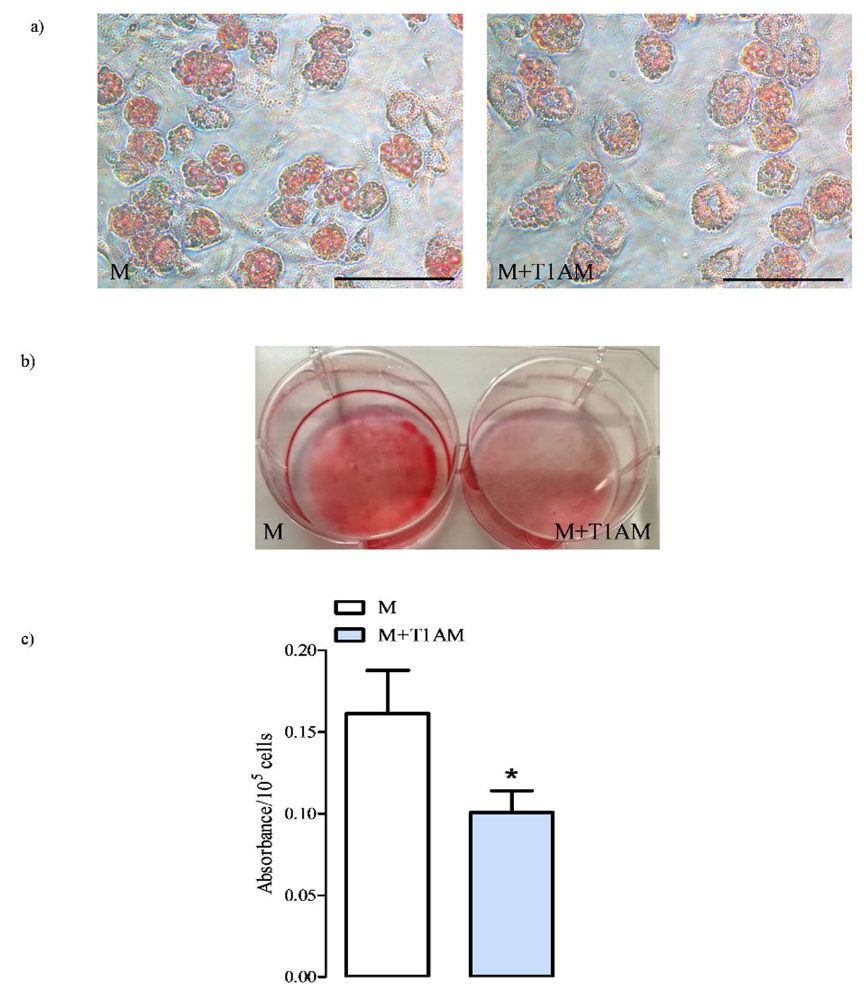
Figure 1. The lipid content of cells with medium (M) and M + T1AM cells. M and M + T1AM cells were obtained as described in the Materials and Methods, and their lipid droplets were visualized (Panel a) and quantified (Panel c) by Oil-red O staining. A representative picture of a cell stained directly in culture wells taken with an inverted microscope is shown in Panel ( b ). The absorbance at 510 nm of the dye extracted from M and M+T1AM cells with isopropyl alcohol is reported in Panel ( c ). The results on the histogram represented the mean ± standard error of the mean (SEM) of the absorbance measured from three different cell preparations (* p < 0.05, vs. M cells). ( a ) The image magnification is 40×; scale bar 100 μm.